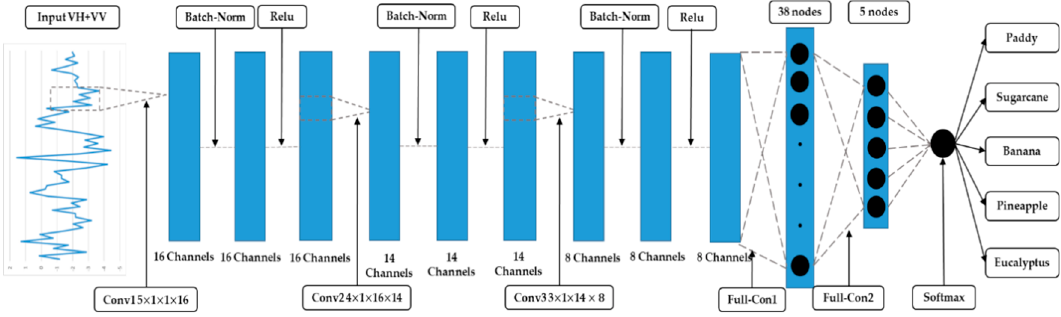
Figure 6. Architecture of the optimal one-dimensional convolutional neural network.